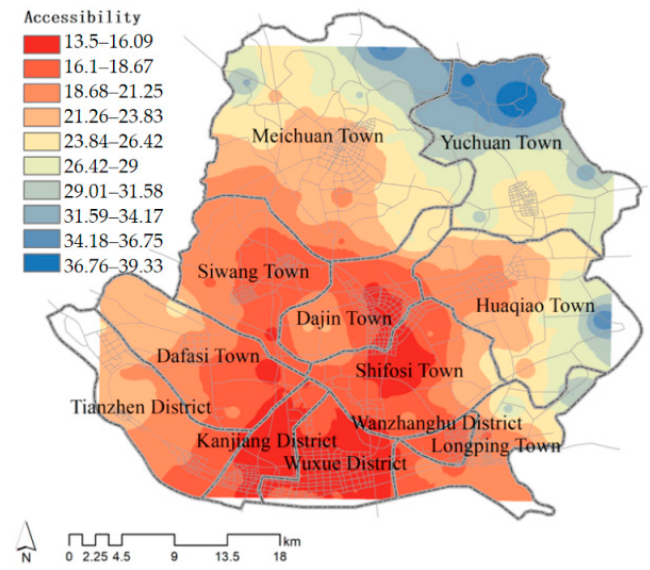
Figure 10. Accessibility analysis based on travel time.